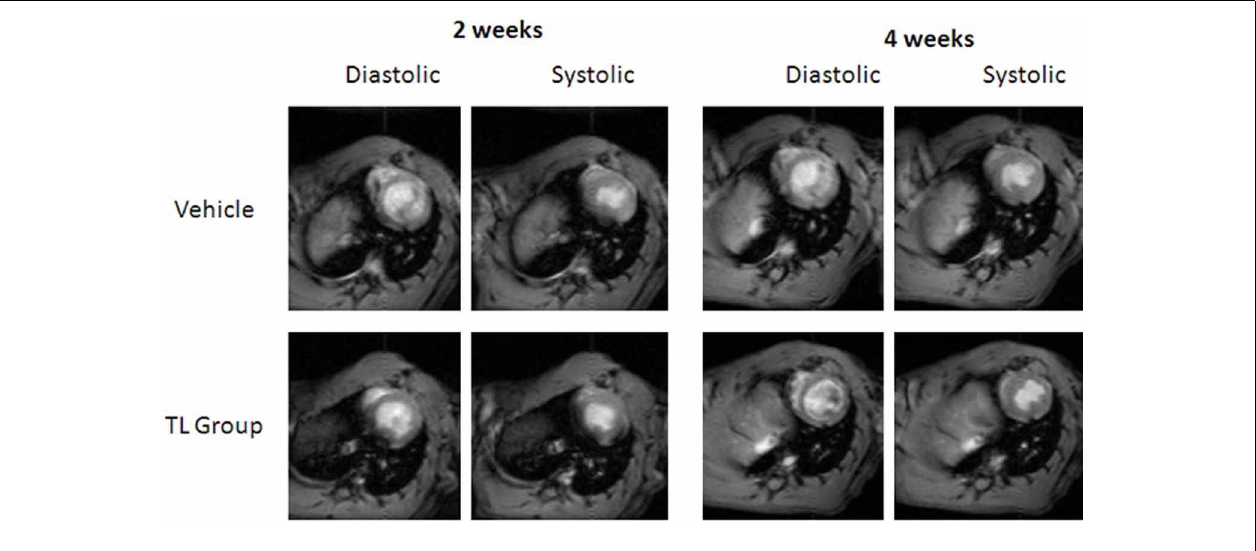
FIGURE 2 | MRI images showing similar cardiac structure at systole and diastole, from mid-study (2 weeks) and at end of study (4 weeks), among TB4-treated (bottom row) and